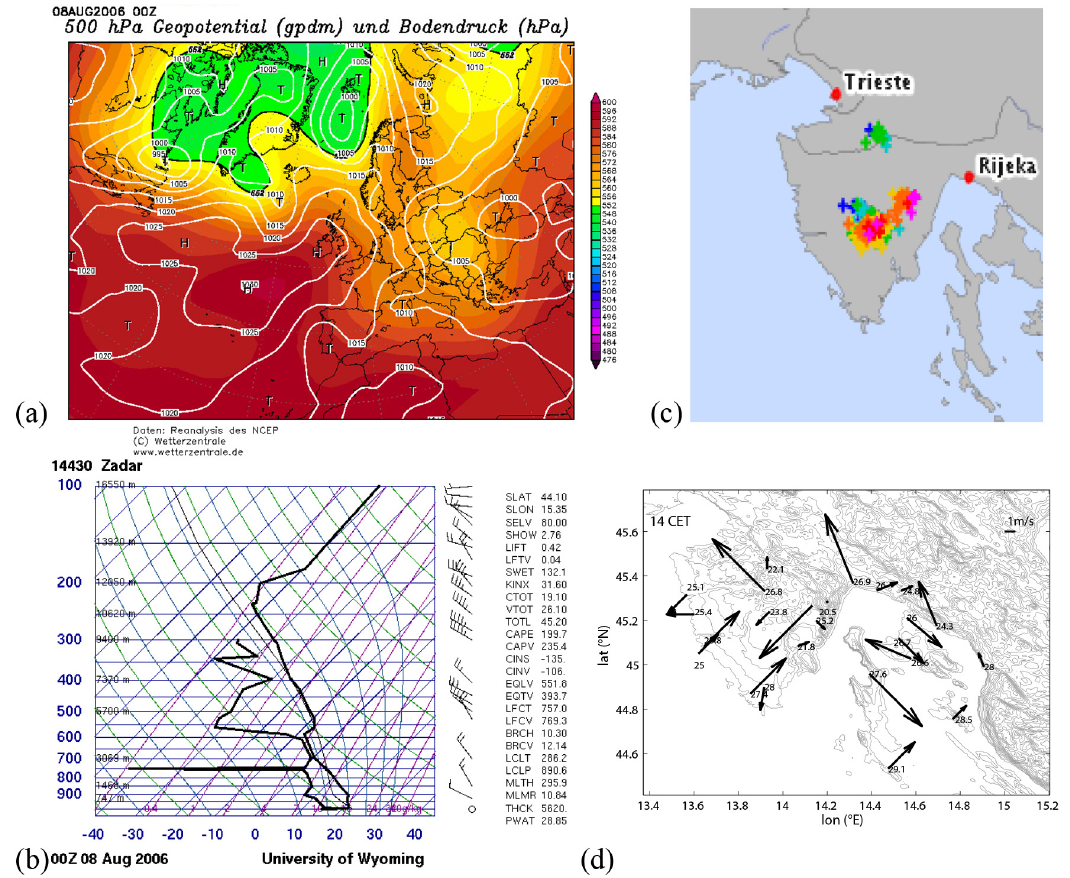
Fig. 6. Case C2, 8 August 2006: (a) surface and 500hPa pressure distribution at 00:00UTC (=01:00CET); (b) radio sounding profiles plotted on a skew T-log p diagram in combination with convective indices in Zadar (44.10 ◦ N/15.35 ◦ E) station at 00:00UTC (=01:00CET); (c) lightning distribution from 13:00 to 14:00CET from LINET network (Betz et al., 2009). The coloured crosses indicate the detection of lightning, same as in Fig. 2c; (d) the measured 10m wind vectors (ms − 1 ) and 2m air temperatures ( ◦ C) at 14:00CET (measuring sites in Fig.